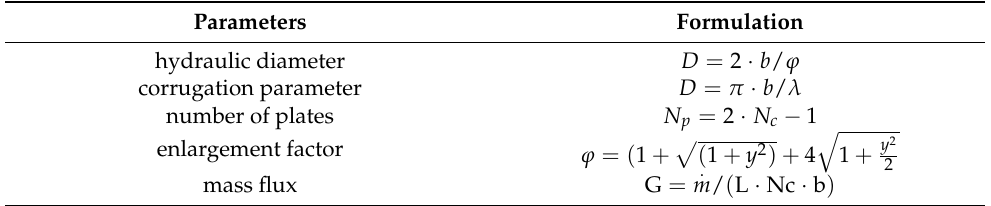
. m is the mass flow rate. m 